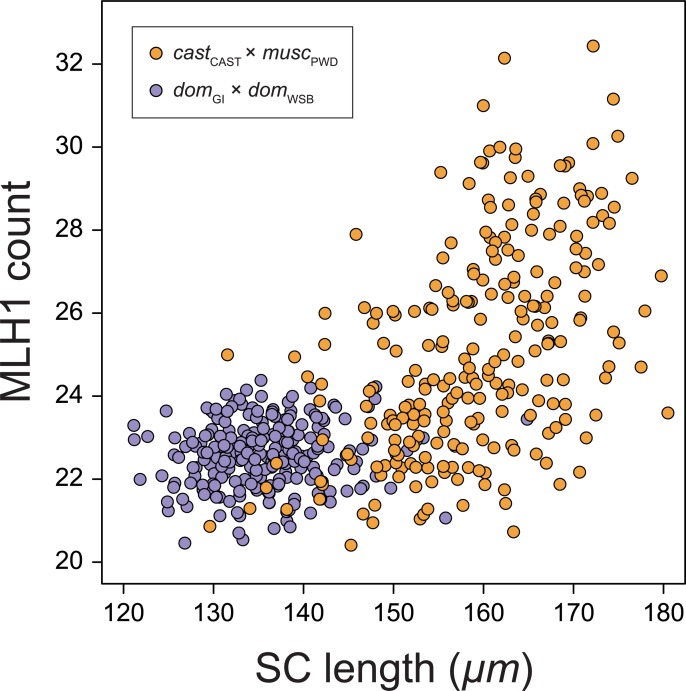
Mean MLH1 foci count and SC length from each cross.Mean MLH1 count and SC length from the same F2 individuals. Those from the castCAST × muscPWD cross in orange (regression slope (SE): 0.13 (0.01) foci/μm) and from the domGI × domWSB cross in purple (regression slope: 0.01 (0.01) foci/μm).